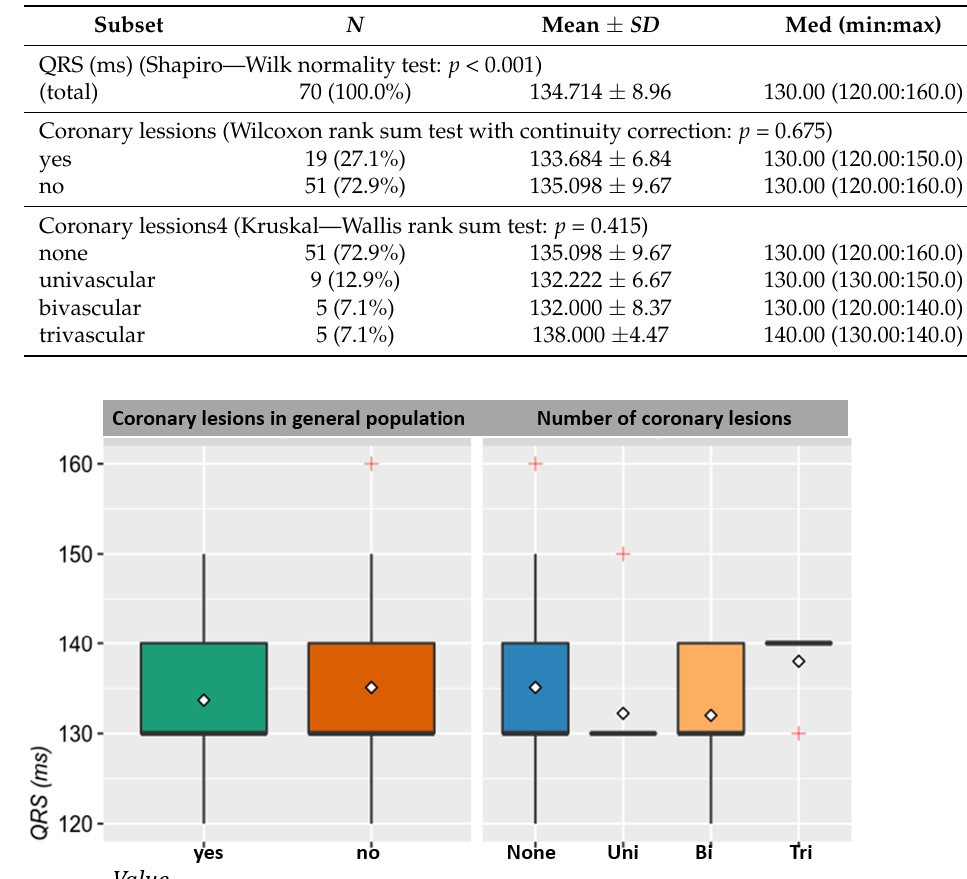
Figure 2. Correlation between the duration of left bundle branch block and macrovascular coro- nary lesions.